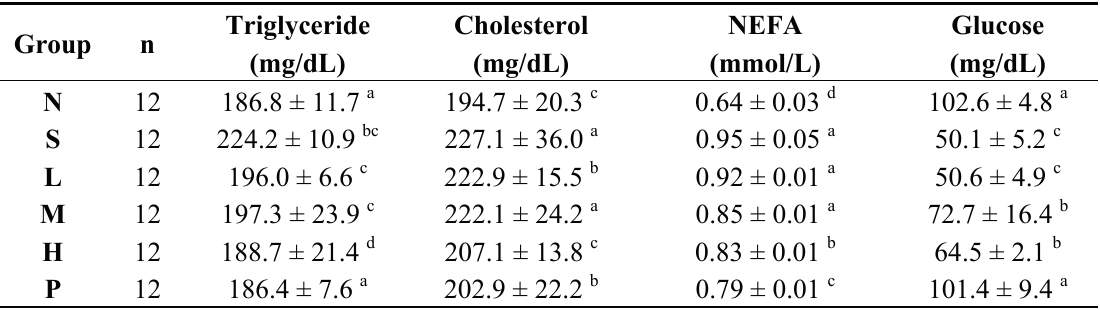
Table 2. Serum triglyceride, cholesterol, NEFA, and glucose concentrations of LPS-induced sepsis mice. Triglyceride Cholesterol NEFA Glucose Group n (mg/dL) (mg/dL) (mmol/L) (mg/dL) N 12 186.8 ± 11.7 a 194.7 ± 20.3 c 0.64 ± 0.03 d 102.6 ± 4.8 a S 12 224.2 ± 10.9 bc 227.1 ± 36.0 a 0.95 ± 0.05 a 50.1 ± 5.2 c L 12 196.0 ± 6.6 c 222.9 ± 15.5 b 0.92 ± 0.01 a 50.6 ± 4.9 c M 12 197.3 ± 23.9 c 222.1 ± 24.2 a 0.85 ± 0.01 a 72.7 ± 16.4 b H 12 188.7 ± 21.4 d 207.1 ± 13.8 c 0.83 ± 0.01 b 64.5 ± 2.1 b P 12 186.4 ± 7.6 a 202.9 ± 22.2 b 0.79 ± 0.01 c 101.4 ± 9.4